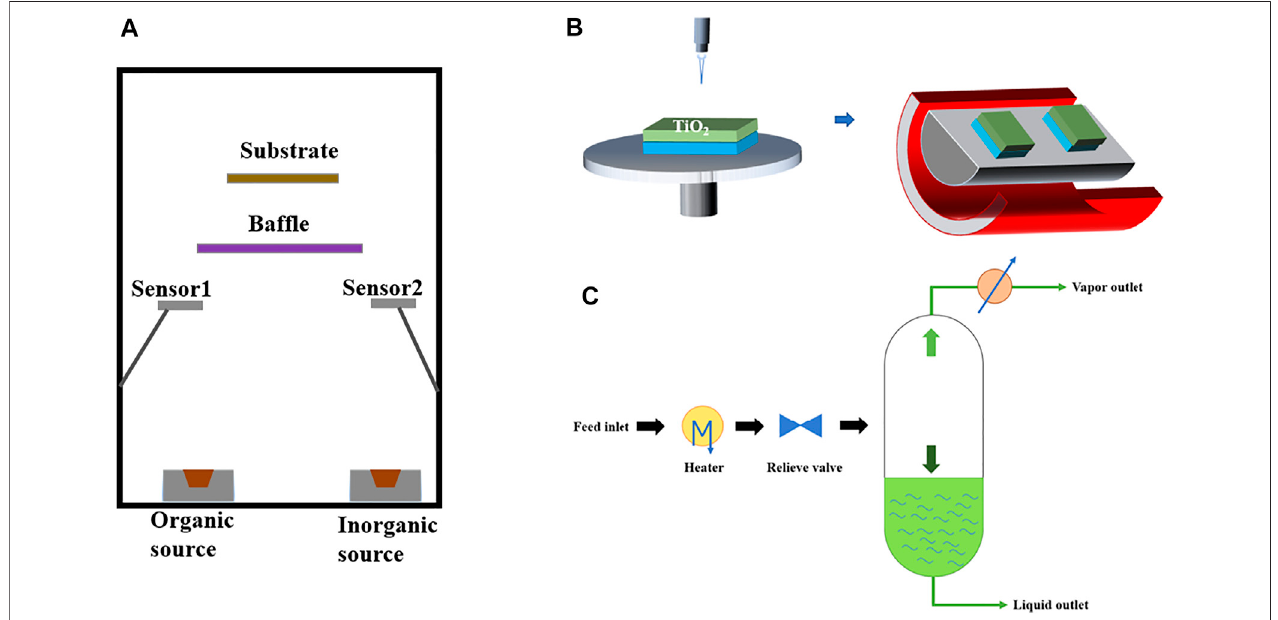
FIGURE 4 | Classi fi cation of various vapor phase deposition techniques for PSCs.